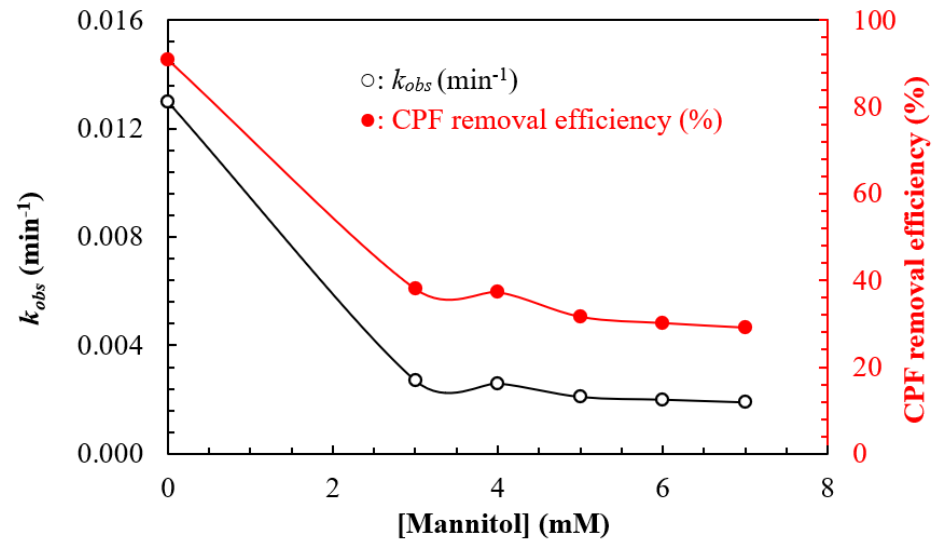
14 of 23 Figure 12. Plot of 1/ k obs vs. initial concentration of CPF. 2.2.7. Effect of a Hydroxyl Radical Scavenger To further investigate the degradation mechanism, the oxidative decomposition of CPF catalyzed by Fe III -CS-GLA was evaluated in aqueous solution under the optimized reaction conditions in presence of the specific hydroxyl radical scavenger mannitol [63]. The changes in k obs values and CPF removal efficiency as a function of mannitol concen-